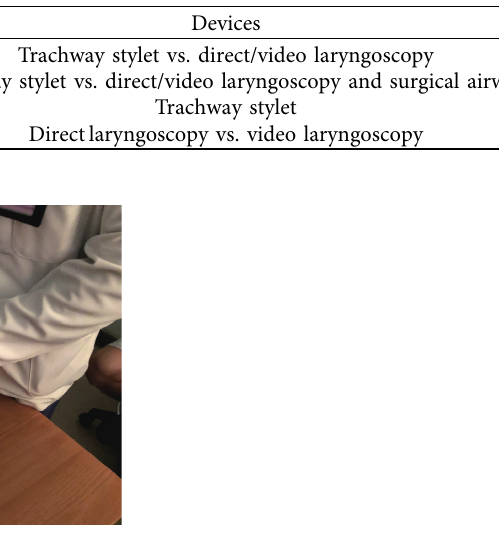
Table 1: Four scenarios of the training program and simulation setting.